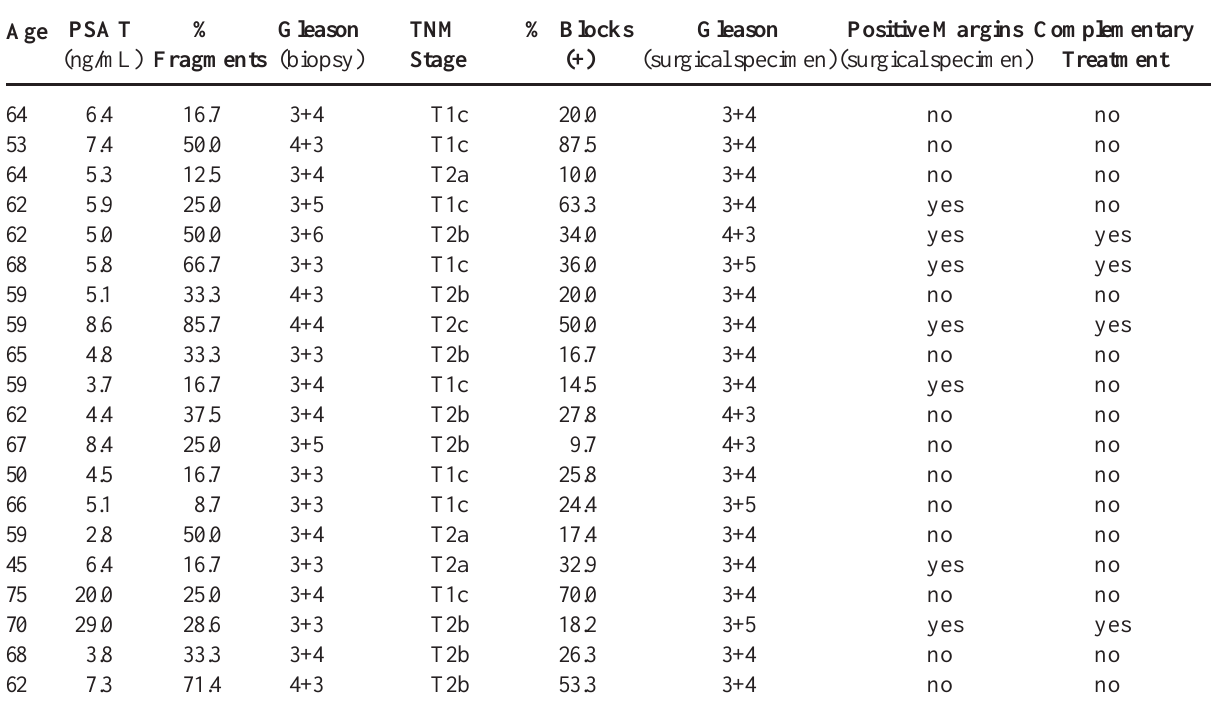
Table 1 – Clinical and morphologic pre and postoperative data of the patients submitted to radical prostatectomy and classified as